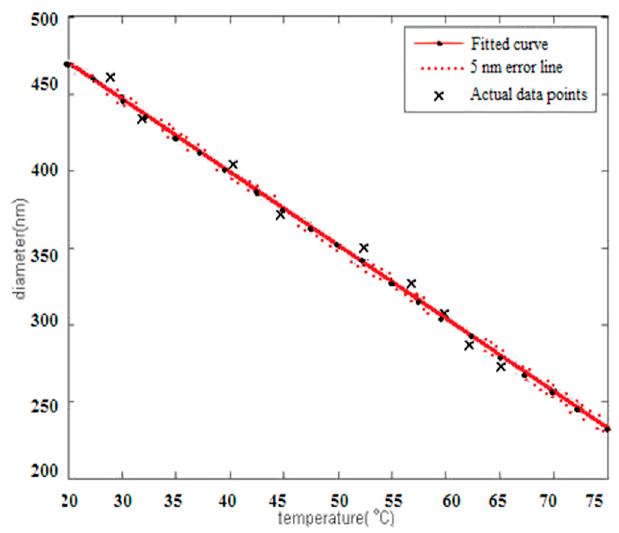
Figure 6. Fitting Curve of Particle Size and Temperature Change.